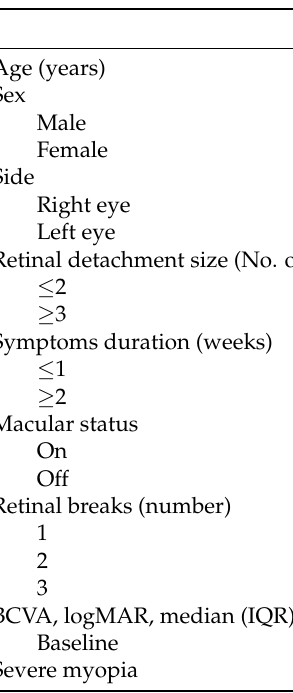
Table 1. Characteristics of